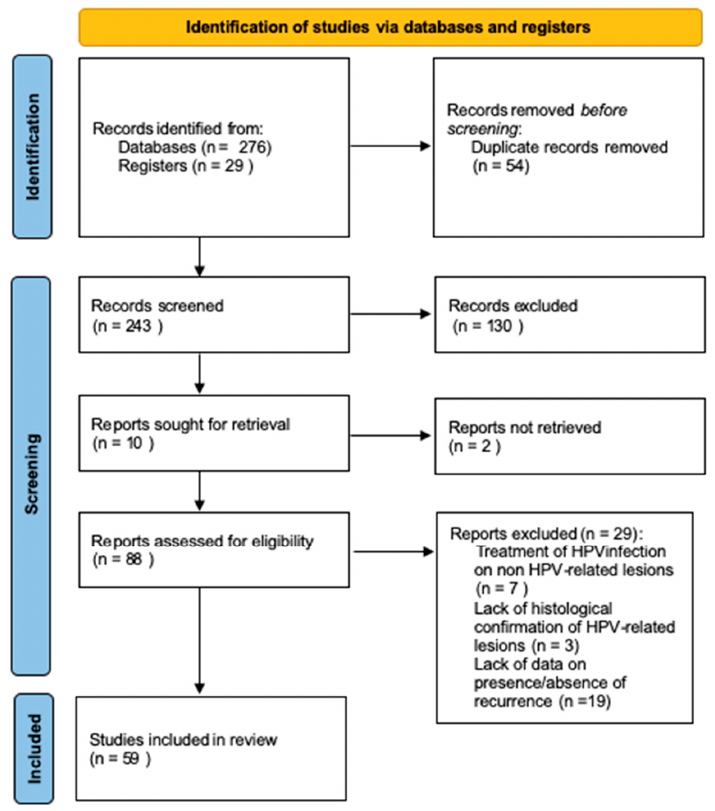
Figure 1. Flowchart systematic review.